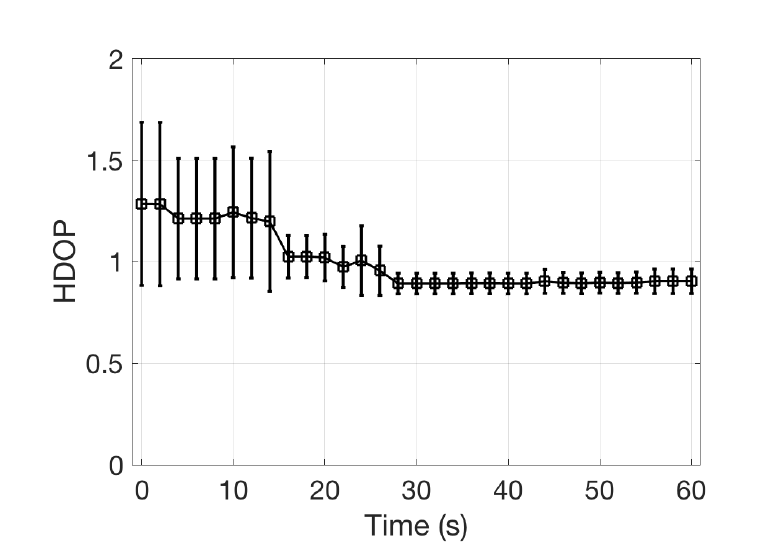
Figure 14. Distribution of the Horizontal Dilution of Precision (HDOP) as a function of the time from the first